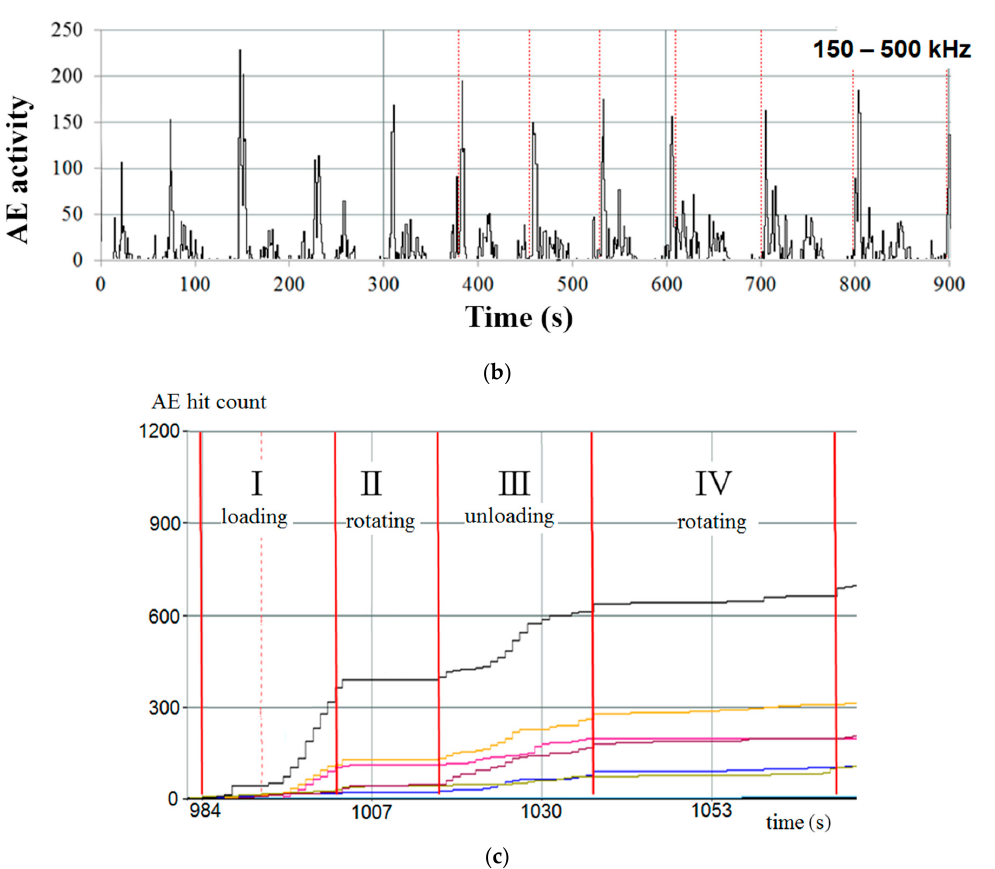
Figure 26. AE activity when using 30–500 kHz ( a ) and 150–500 kHz ( b ) frequency filters. Correlation of AE hit count with the cycle of operation of the dragline excavator when using 150–500 kHz frequency range ( c ).